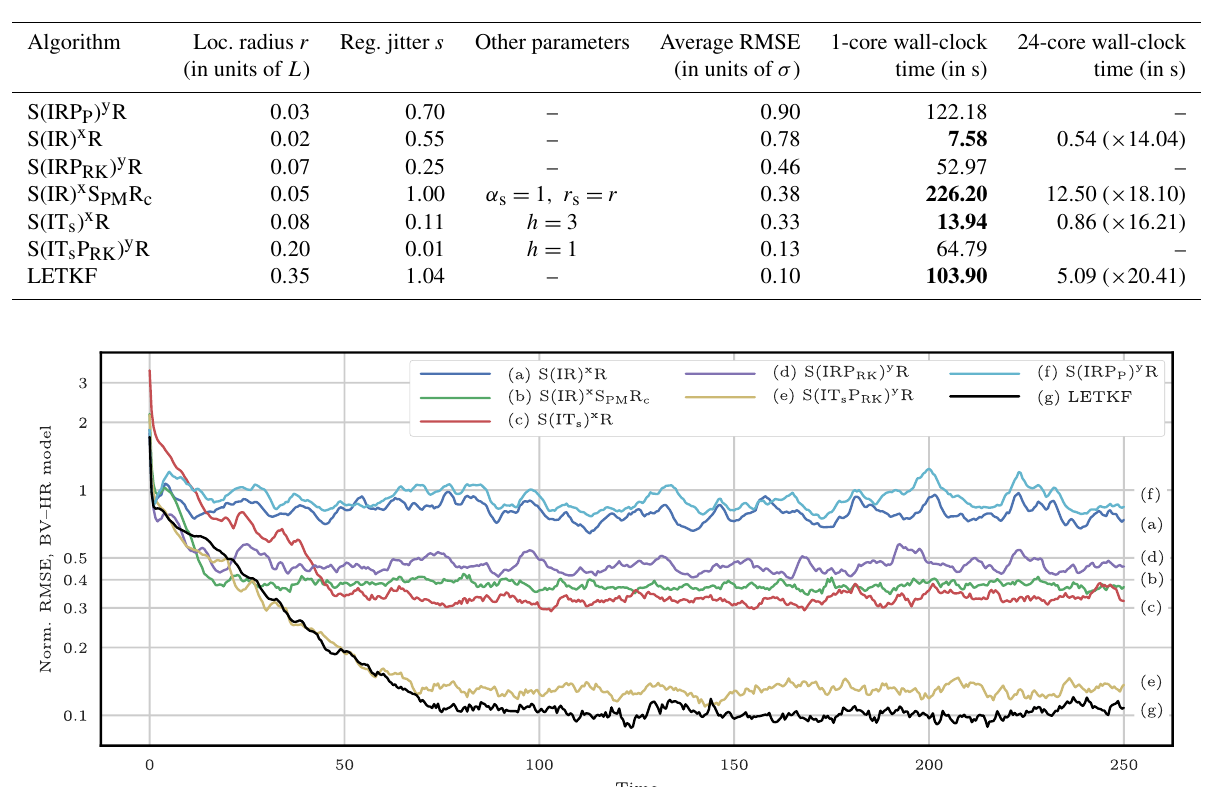
Table 5. Characteristics of the algorithms tested with the BV model in the HR configuration (Fig. 22). The LPF x s use zero integration jitter ( q = 0) and N b = N x blocks of size 1 grid point. The LPF y s also use zero integration jitter ( q = 0). For the LETKF, the optimal multiplicative inflation is reported in the regularisation jitter column. For the S(IR) x S PM R c algorithm, the optimal regularisation jitter bandwidth ˆ h is reported in the regularisation jitter column as well. The average RMSE is computed over the final 300 assimilation steps and is given in